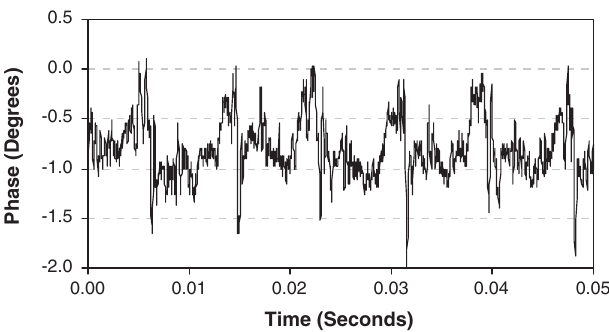
FIG. 11. Phase jitter measurement for the case with the DSP controller activated as shown in Fig. 7 but with an expanded vertical